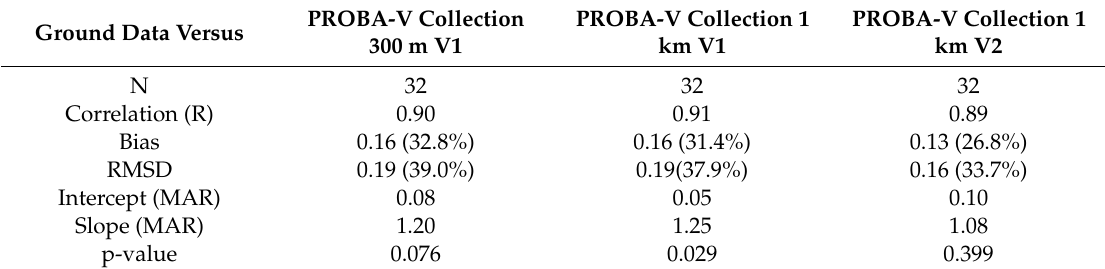
Figure 10. Comparison of the satellite fCOVER products (Collection 300 m V1 ( a ), Collection 1 km V1 ( b ) and Collection 1 km V2 ( c )) with ground-based maps. Numbers indicate the sample, and colours indicate the site (Table 2). Dashed lines correspond to the 1:1 line and optimal and target requirements, and the red line corresponds to the linear fit using MAR. Table 13. Accuracy assessment with ground measurement statistics for different satellite fCOVER products at 3 km spatial resolution. Relative values (%) are shown in brackets.